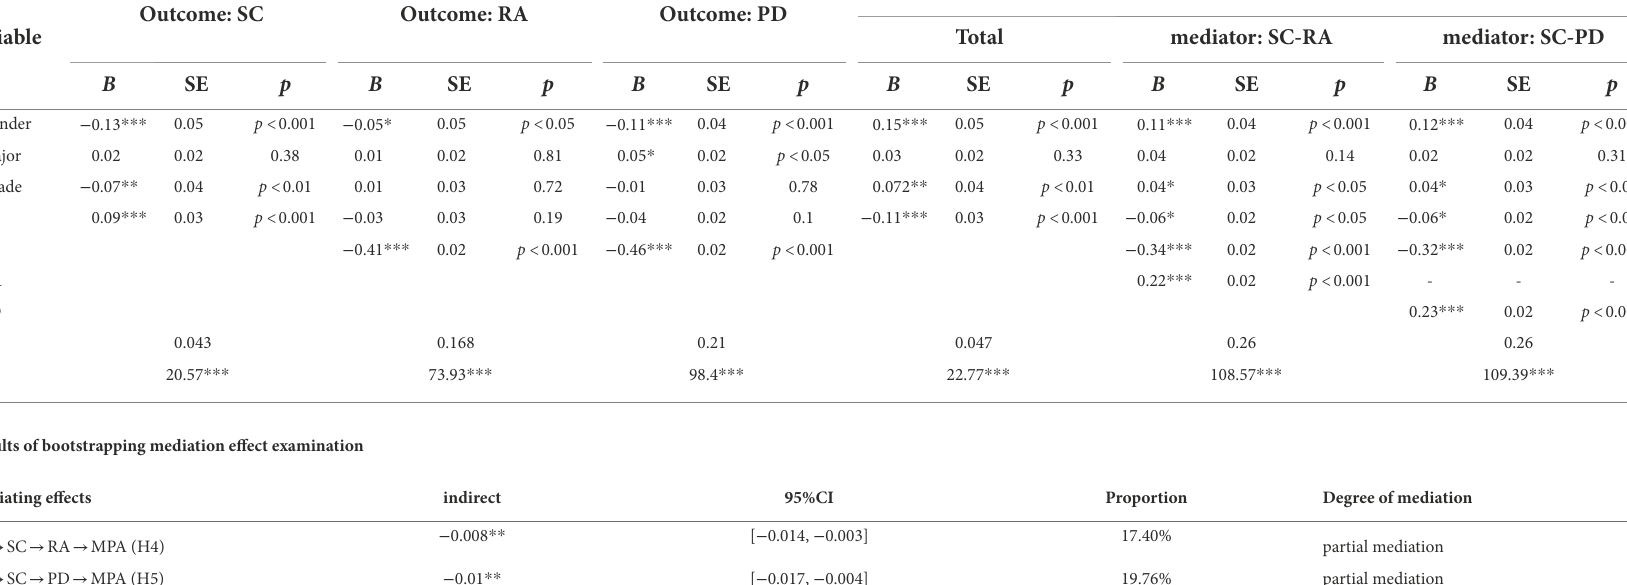
TABLE 4 Regression analysis of the chain mediating